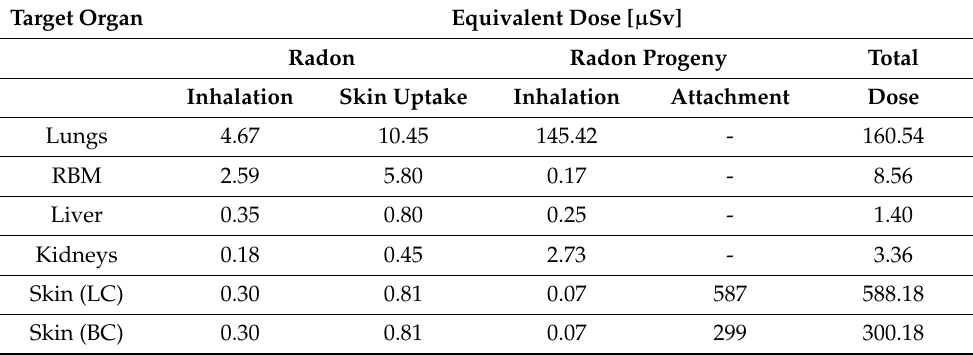
Table 7. Comparison of organ doses received in the vapor bath for different exposure pathways. Target Organ